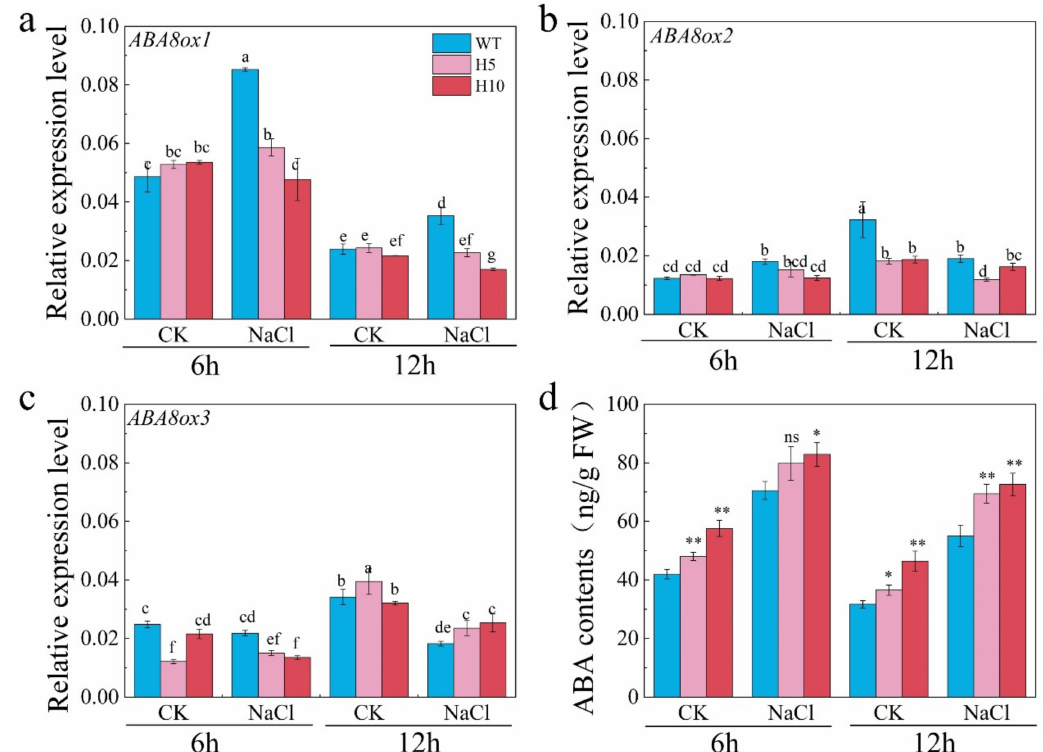
Figure 4. NR-associated NO increased expression of ABA catabolism genes during seed germination under salt stress. ( a – c ) Expressions of OsABA8ox1 , OsABA8ox2 and OsABA8ox3 in WT, H5 and H10 germinated under water and 100 mM NaCl solution; ( d ) ABA content of WT and triple mutant seeds germinated under water. The data are the means of three independent replications ( n = 20) ± SD. The asterisk (* and **) indicates a significant difference at the p < 0.05 and p < 0.01 level, respectively, and ns means not significant, by Student’s t -test. Different letters a, b, c and others indicate significant differences, p < 0.05, by Duncan’s test